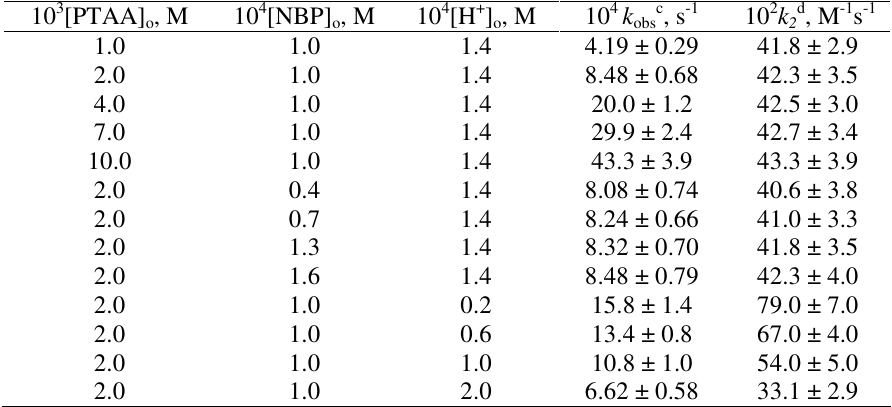
Table 1. Pseudo-first-order and second-order rate constants for the oxidation of PTAA by NBP in aqueous acetonitrile at 298 K